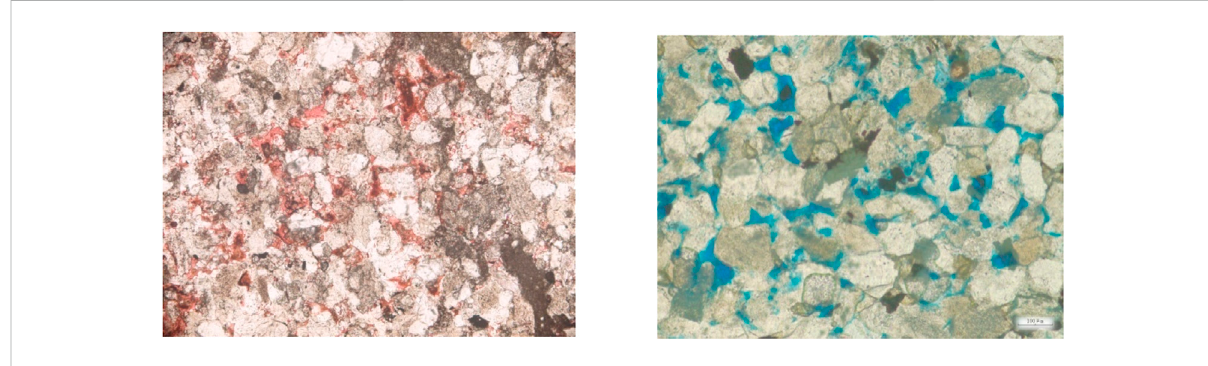
FIGURE 4 Reservoir space types of clastic rocks in Niubao Formation.